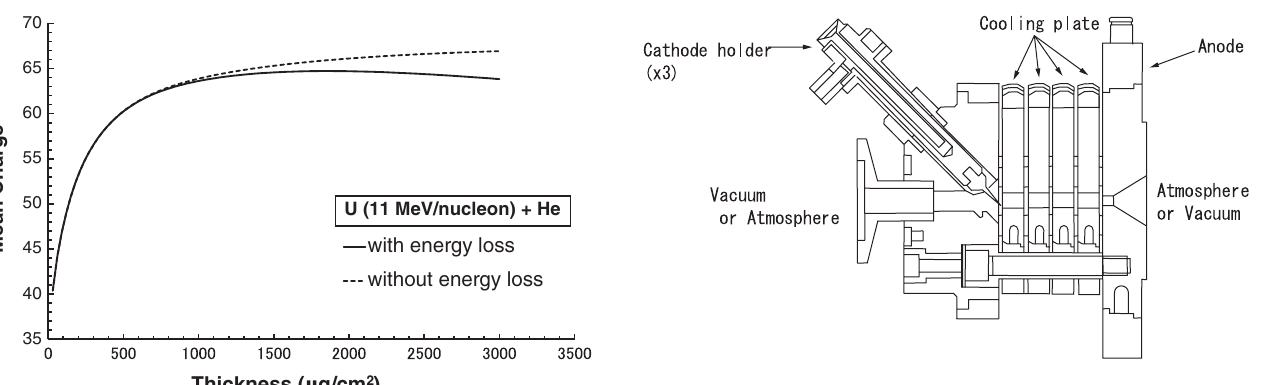
FIG. 8. Schematic of plasma window for keeping the vacuum separated from atmosphere. It consists of three cathode holders, cooling plates, and an anode plate to fill the aperture with arc plasma.